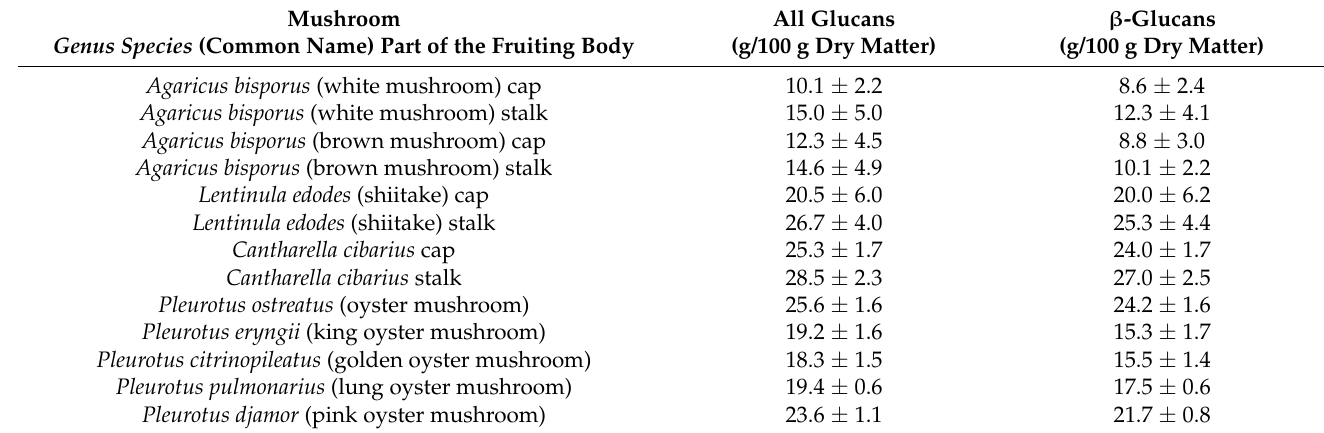
Table 1. All glucans and β -glucan content in different commercially cultivated